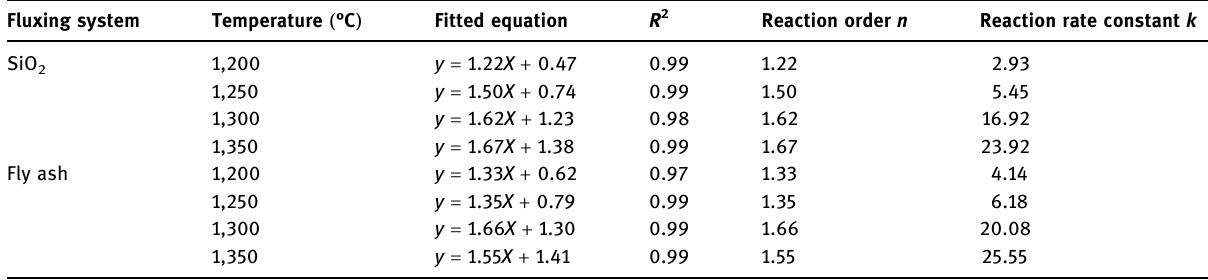
Table 4: Linear fi t results for di ff erent fl uxing systems Fluxing